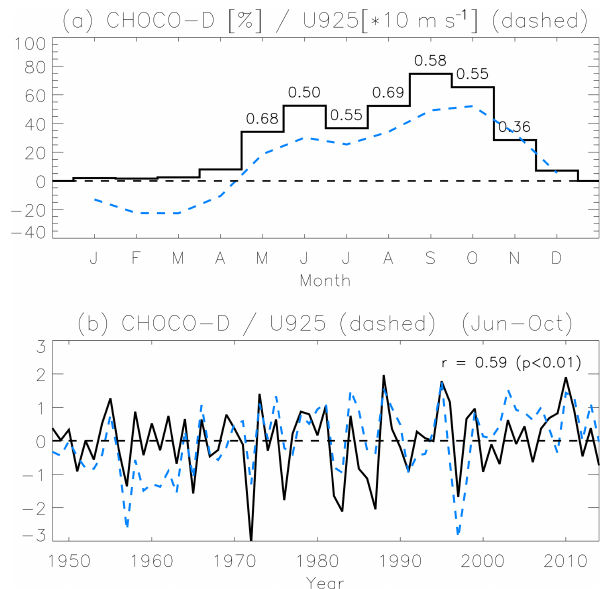
Figure 5. (a) Monthly averages (1948–2014) of the NCEP-NCAR zonal wind at 925hPa averaged over the 5–7.5 ◦ N, 90–80 ◦ W area (blue dashed line) and monthly averages of the CHOCO-D index for the same period in percentage of days in a month with prevail- ing wind flowing from the southwest (black line). Numbers over the CHOCO-D values indicate the monthly correlation between both series for the 1948–2014 period. Only correlations statistically sig- nificant ( p < 0 . 01) are displayed. Note that the scale of the wind is expressed as 10 ms − 1 to ease comparison. (b) Standardized tem- poral series (June to October average) of the CHOCO-D index and the NCEP-NCAR zonal wind at 925hPa averaged over 5–7.5 ◦ N, 90–80 ◦ W (blue dashed